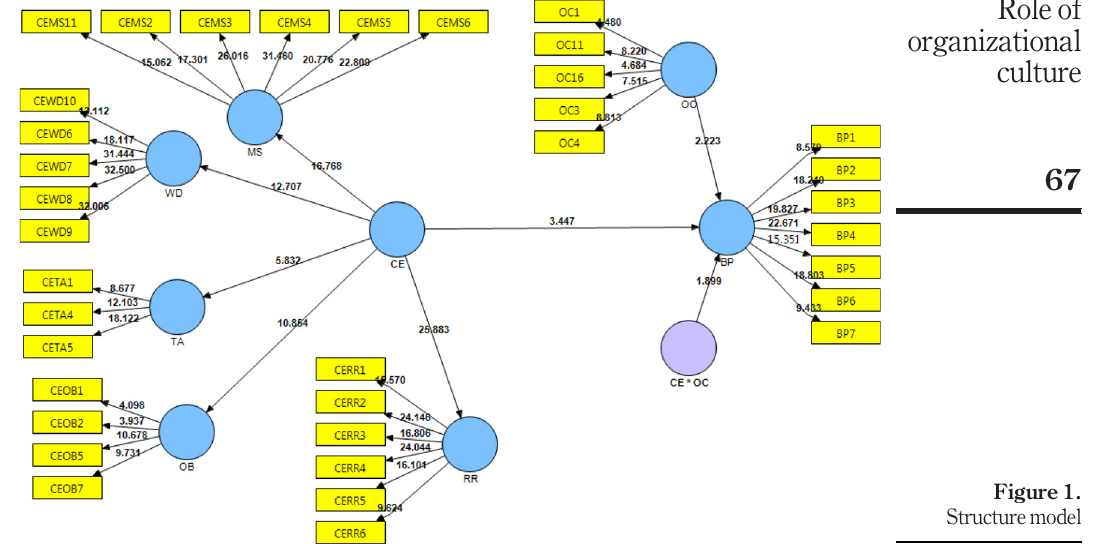
Figure 1. Structure